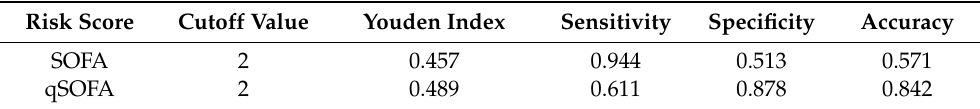
Table 3. Sensitivities, specificities, and accuracy rates of SOFA and qSOFA for predicting in-hospital mortality. Risk Score Cutoff Value Youden Index Sensitivity Specificity Accuracy SOFA 2 0.457